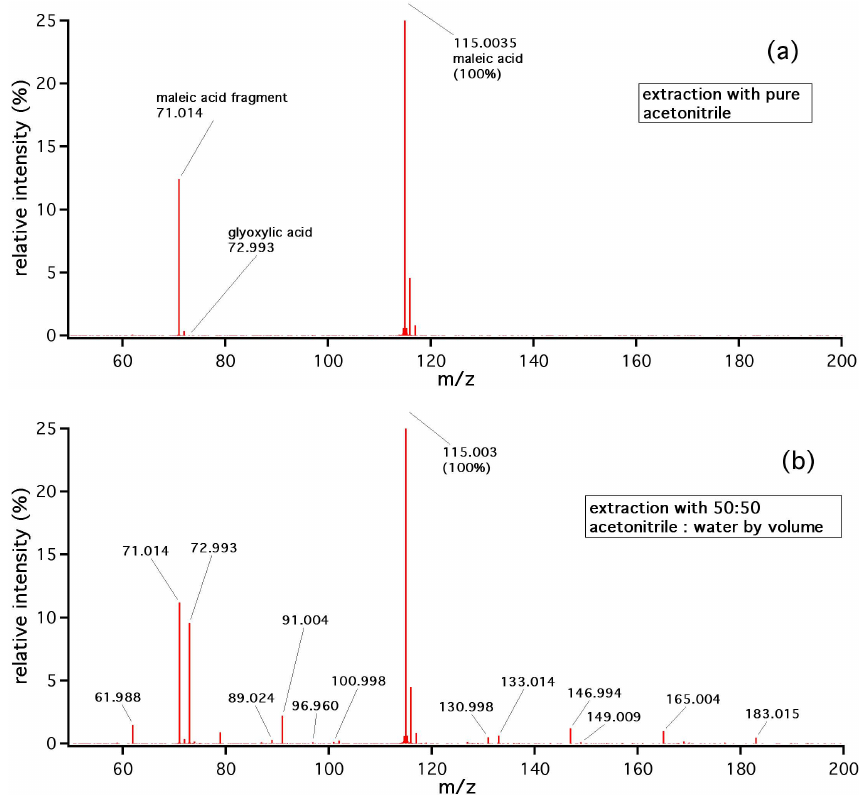
Fig. 5. Comparison of the mass spectra obtained for the same experimental run (dry ozonolysis of maleic acid particles on a Teflon filter) using different extraction techniques. For spectrum (a) the sample was extracted using pure acetonitrile and for spectrum (b) a 50:50 by volume mixture of water and acetonitrile was used as extraction solvent, demonstrating clearly the additional reactivity (and potential artefacts) induced by the aqueous extraction